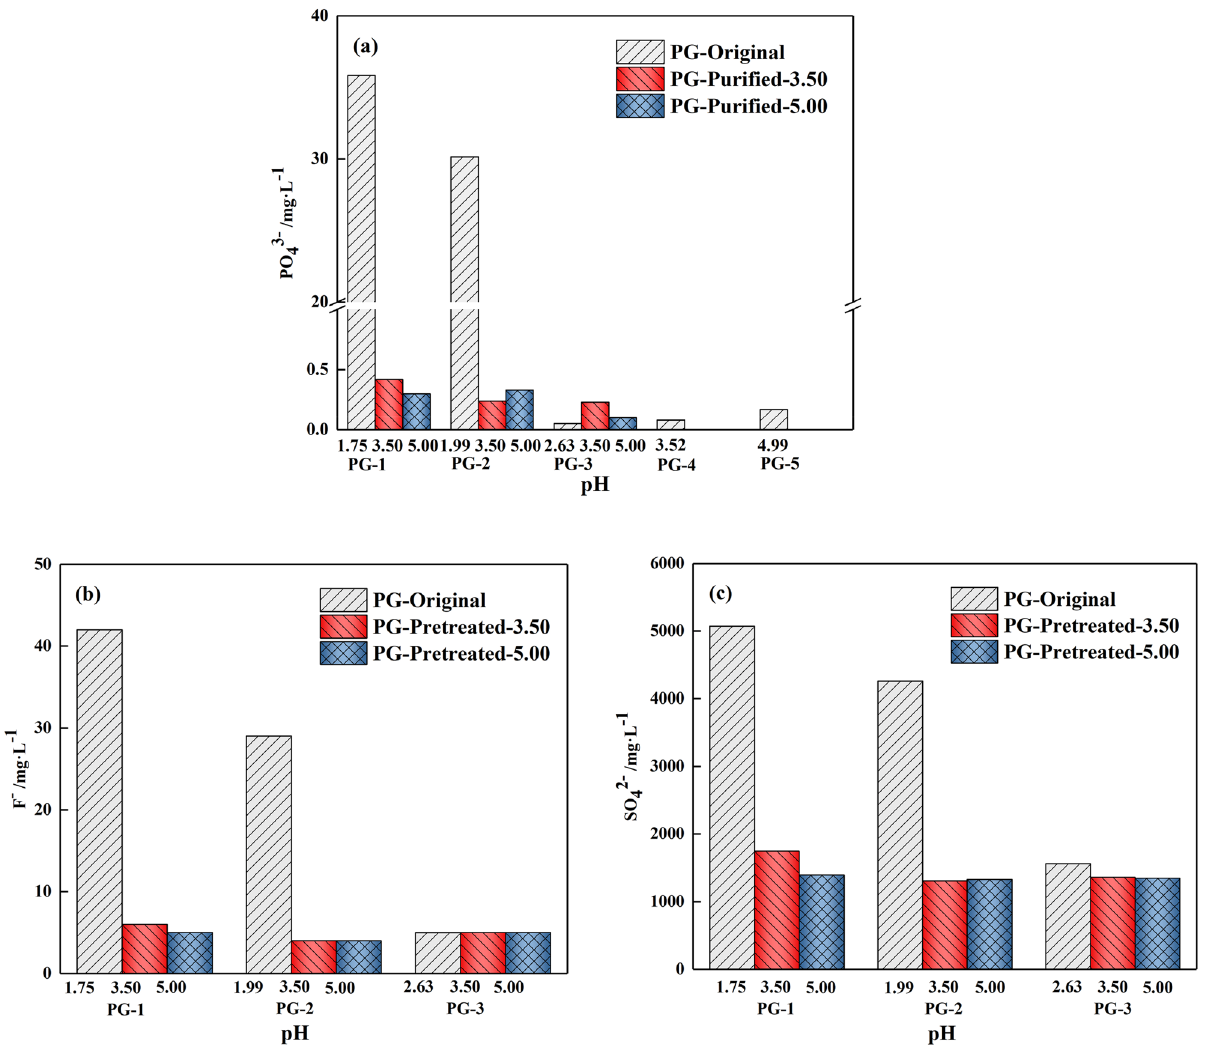
Figure 11. Variation of impurities in bleeding water: ( a ) PO 4 3− , ( b ) F − , ( c ) SO 4 2−